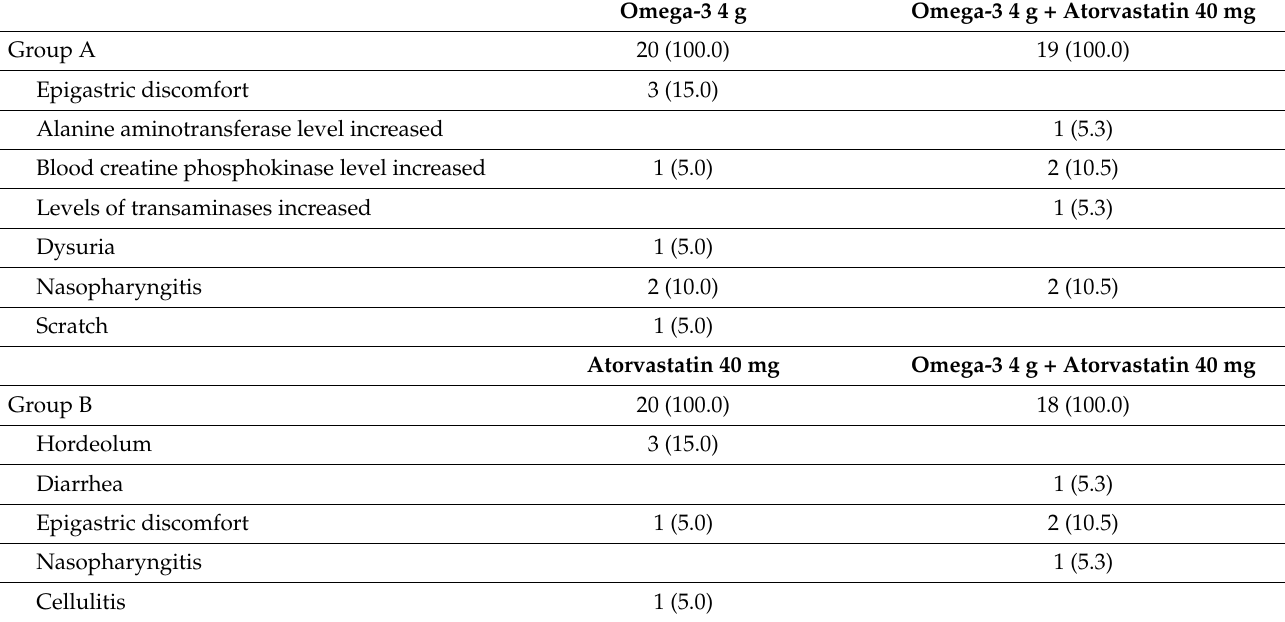
Table 4. Summary of the adverse events related to